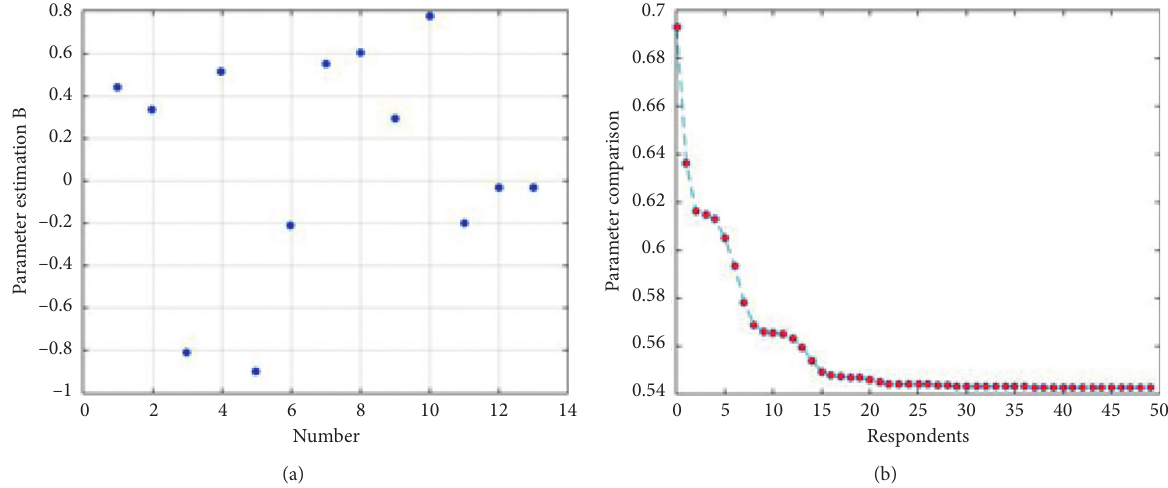
Figure 9: Likelihood function optimization diagram of the mixed logit